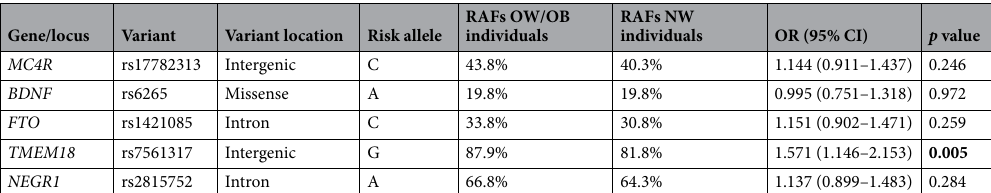
Table 3. Comparison of RAFs of the variants between OW/OB and NW individuals along with the association of the variants with overweight/obesity. OW/OB overweight/obese, NW normal-weight, RAFs risk allele frequencies, OR odds ratio, CI confidence interval. The data represents risk allele frequencies (RAFs) in overweight/obese and normal-weight individuals along with odds ratios and confidence intervals in parenthesis. Association was tested using multinomial logistic regression assuming an additive model. The analysis was performed by adjusting age and gender. An adjusted p value < 0.05 was considered significant. The significant p value is indicated in bold .